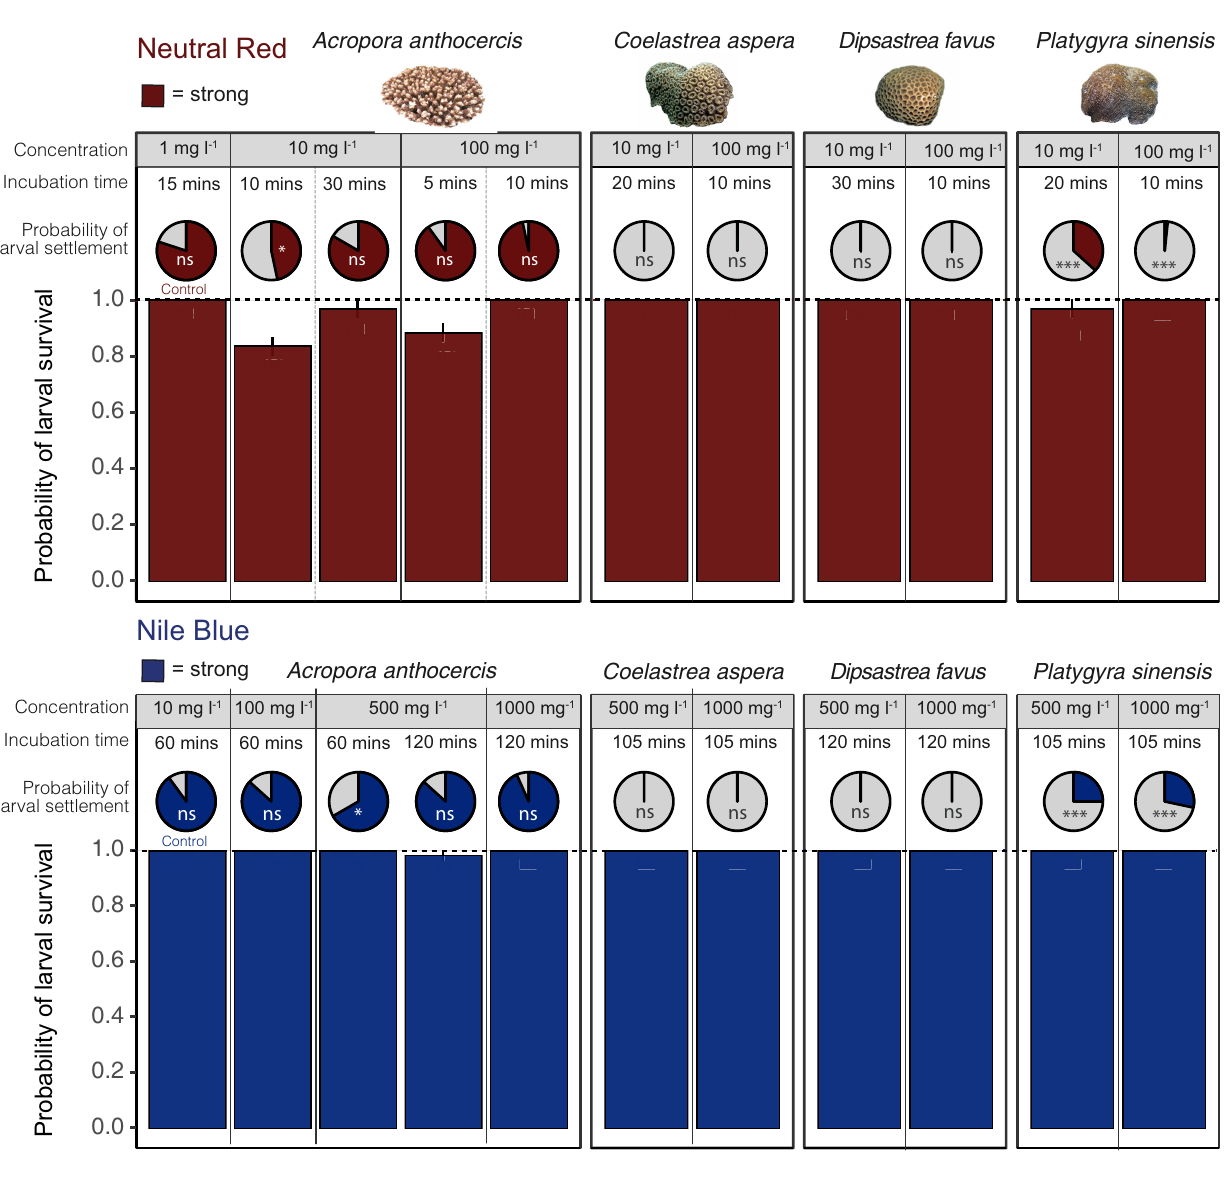
Fig 4. Probability of larval survival and settlement for four species of coral exposed to neutral red and Nile blue stains at different concentration levels and incubation times. For probability of settlement, the filled proportion of the circle indicates the proportion of surviving larvae. Differences in larval survival between treatments shown against controls (dash line), where no mortality was observed (100% survival). Inset notation for probability of settlement indicates significant differences from control within each species at an α of 0.05 ( ns = no significant difference, � = p < 0.05, �� p < = 0.01, ��� = p < 0.001). Images supplied by authors. Data underlying this Figure can be found at https://doi.org/10.25919/4rry-xg84.